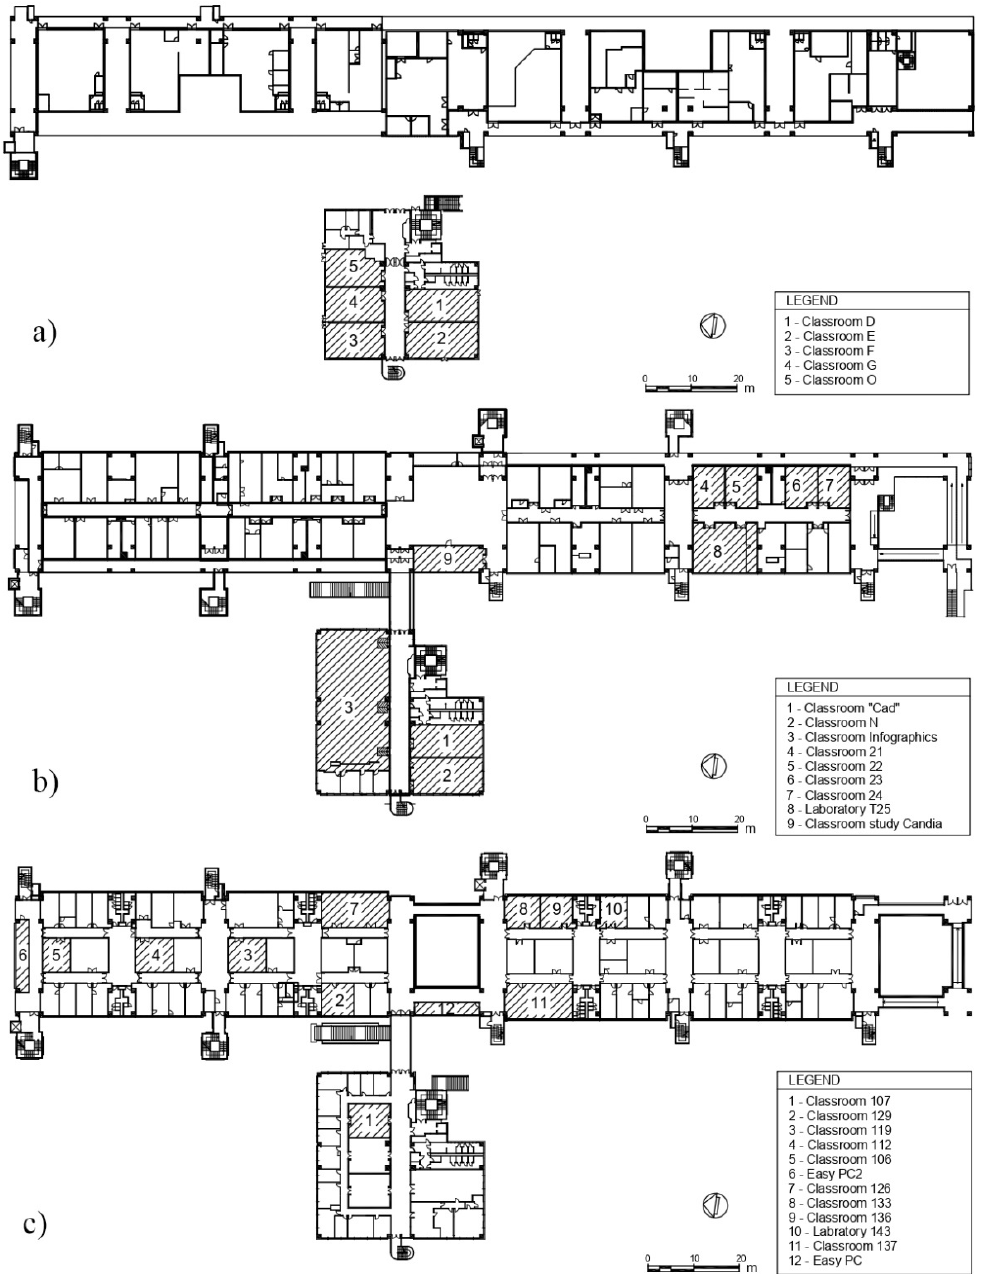
Figure 3. Investigated classrooms: ( a ) Level 1—basement of main building n. 5–6 and ground floor of secondary building n. 9c; ( b ) Level 2—ground floor of main building n. 5–6 and first floor of secondary building n. 9c; ( c ) Level 3—first floor of main building n. 5–6 and second floor of secondary building n. 9c.